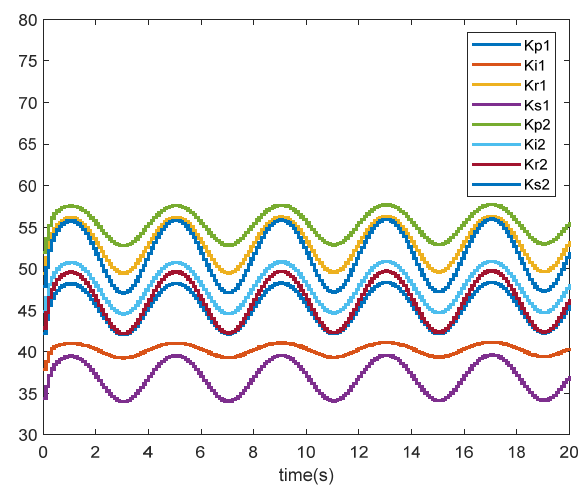
Figure 6. Parameter change of the DDPGPIR controller.